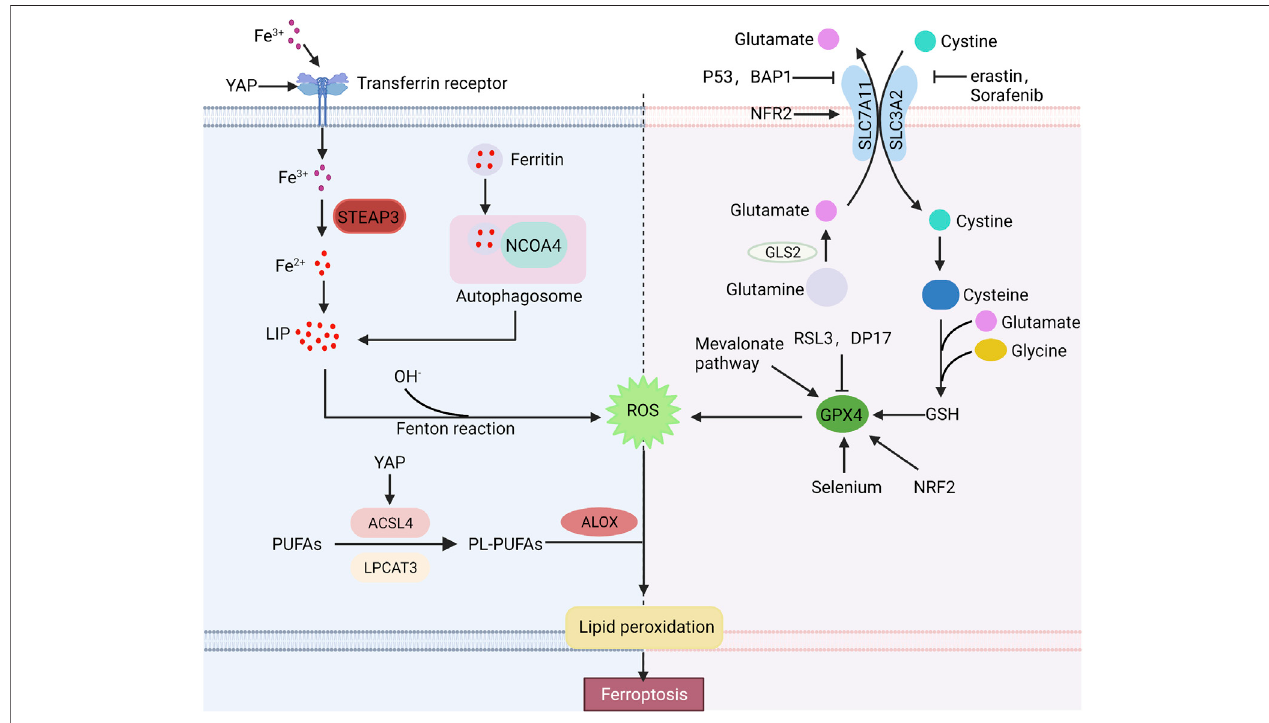
FIGURE 1 | Basic ferroptosis pathways and regulators. Iron metabolism, the xCT-GPX4 pathway and lipid metabolism pathway are the primary metabolisms of ferroptosis. Furthermore, many factors can regulate ferroptosis. Arrows indicate positive effects, and perpendicular bars indicate negative effects.